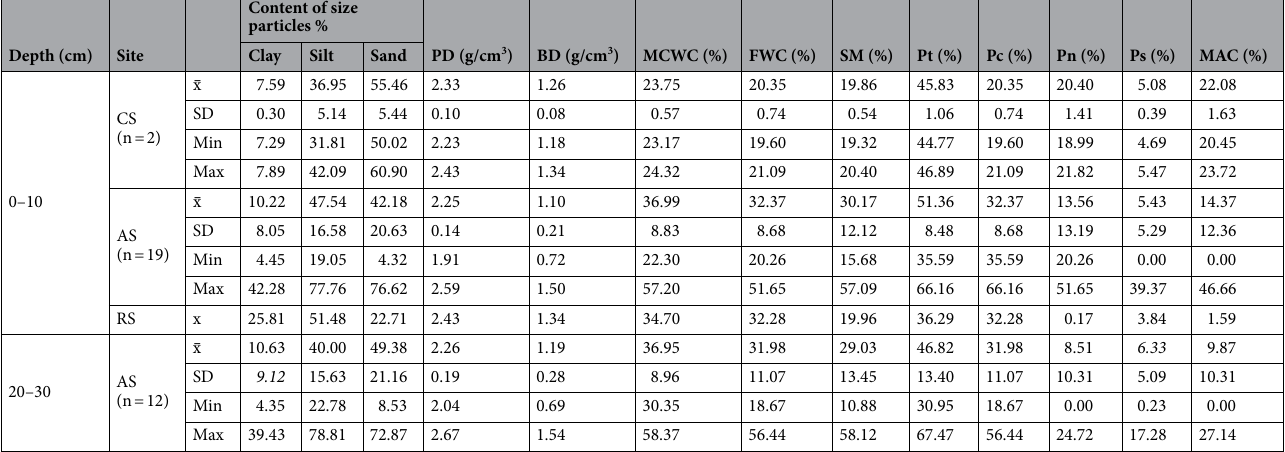
Table 2. Soil physical properties in the soil depth of 0–10 and 20–30 cm in contaminated, alluvial and reference sites with basic statistical characteristics. AS alluvial site, CS contaminated site, RS reference